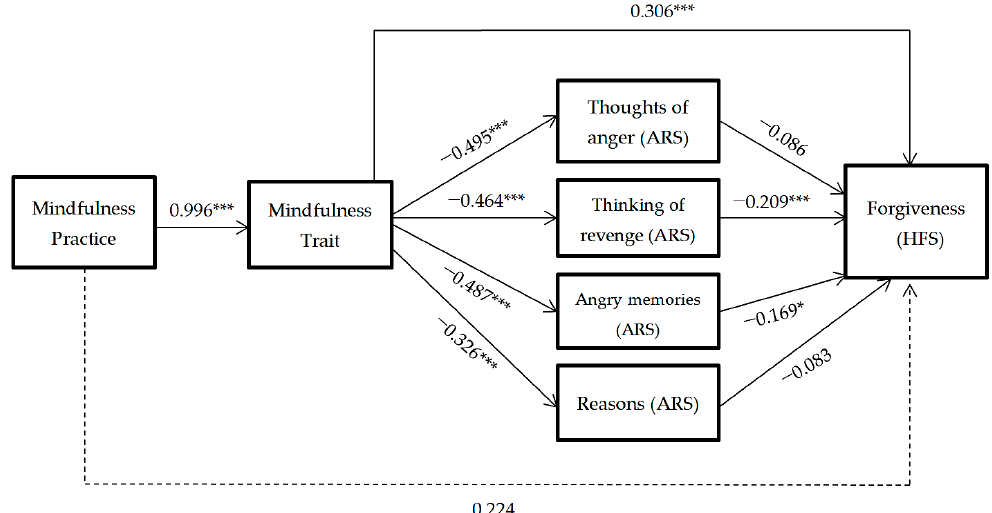
Figure 3. Hypothesized mediation model: spillover effect of mindfulness practice on forgiveness through mindfulness trait and rumination factors. * = p < 0.05, *** = p < 0.001.